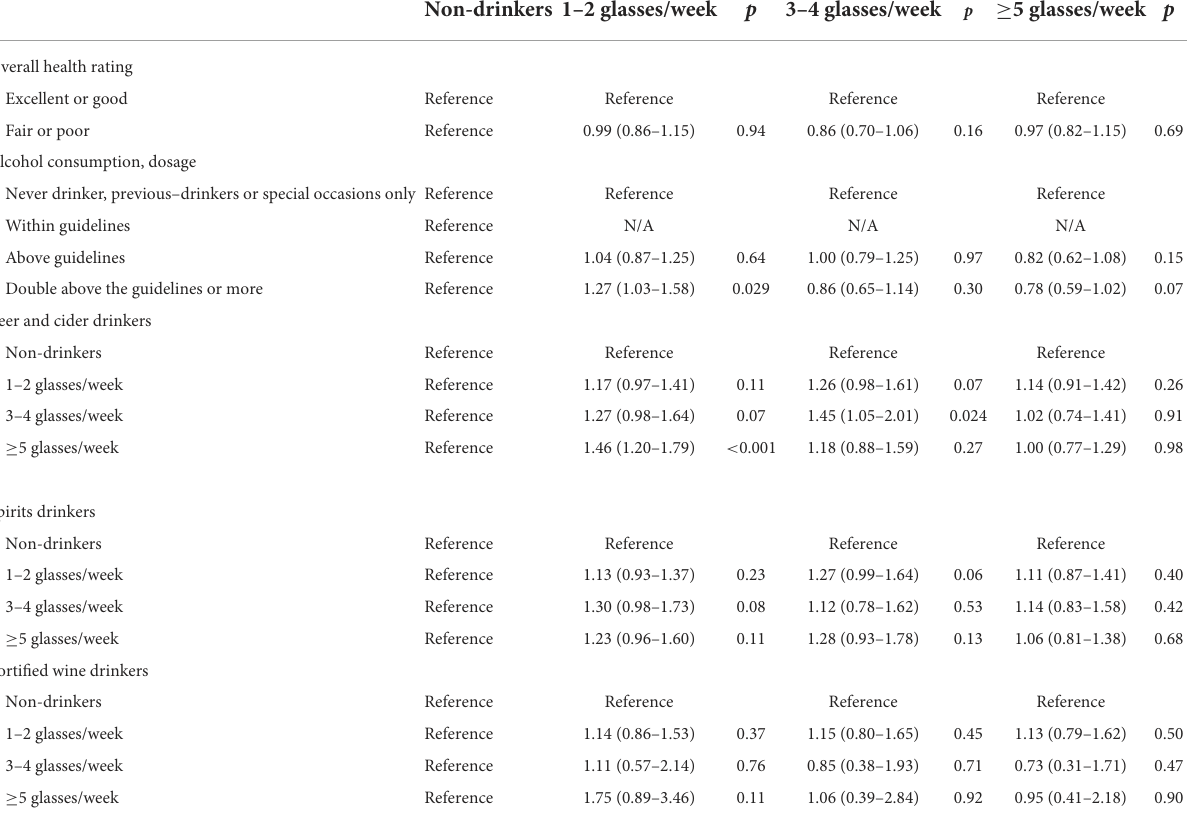
TABLE 8 Odds ratios and 95% CIs for the interaction effect between white wine and champagne and the risk of